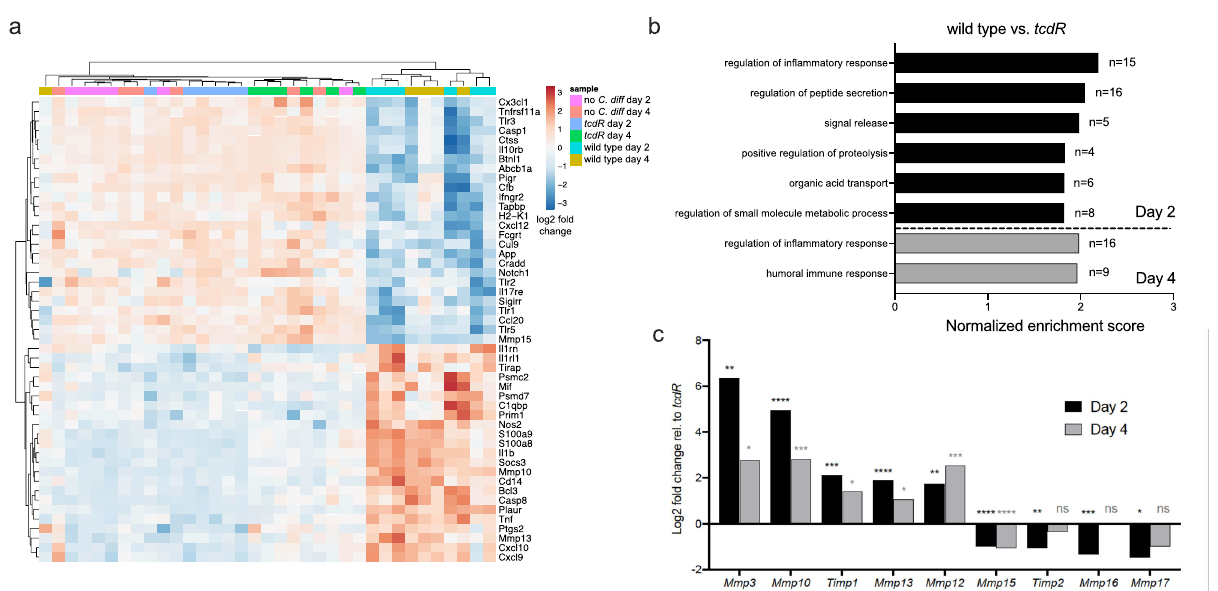
Fig. 3 C. dif fi cile induces expression of numerous transcripts associated with in fl ammation and ECM degradation. a Heatmap of the top 50 differentially regulated transcripts (by adj. p -value) in the ceca of uninfected control (no C. diff ), wild type, and tcdR mice ( n = 5 – 6 mice per group per day). b Gene set enrichment analysis of the differentially expressed genes in wild type mice relative to tcdR mice. c Log2 fold changes of various Mmp s and associated transcripts from wild type vs. tcdR mouse ceca. Signi fi cance for all transcripts except Mmp3 was determined using differential expression analysis within the NanoString nSolver Advanced analysis software (log2 fold change ±1 and adjusted p < 0.05). Mmp3 expression levels were determined via qRT-PCR on cDNA generated from the same RNA used in the NanoString analysis, and individual data points can be seen in Supplementary Fig. 6c (Kruskal – Wallis with Dunn ’ s correction for multiple comparisons). * p < 0.05, ** p < 0.01, *** p < 0.001, **** p <